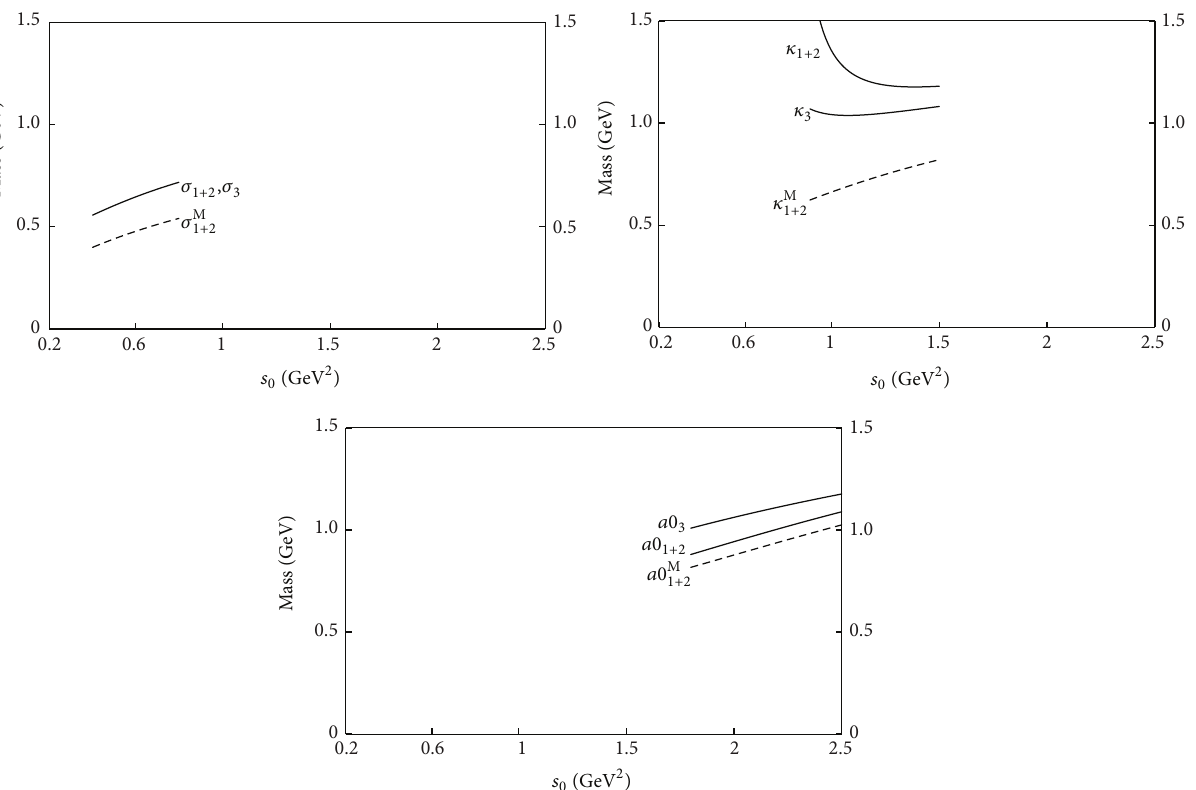
Figure 5: Mass of light scalar mesons 𝑓 0 (500) , 𝜅(800) , and 𝑎 0 (980) ( 𝑓 0 (980) ) as functions of the threshold value 𝑠 0 . The Borel mass 𝑀 𝐵 for 𝑓 0 (500) , 𝜅(800) , and 𝑎 0 (980) ( 𝑓 0 (980) ) are chosen to be 0.50 , 0.60 , and 0.80 GeV 2 , respectively. The solid curves are obtained using the tetraquark currents 𝜎 1+2 , 𝜎 3 , 𝜅 1+2 , 𝜅 3 , 𝑎0 1+2 , and 𝑎0 3 (see definitions in (23), (24), (25), and (26)), while the dashed curves are obtained using the modified currents 𝜎 mod 1+2 , 𝜅 mod 1+2 , and 𝑎0 mod 1+2 (see definitions in (35)). The results for 𝑓 0 (980) are the same as those for 𝑎 0 (980)